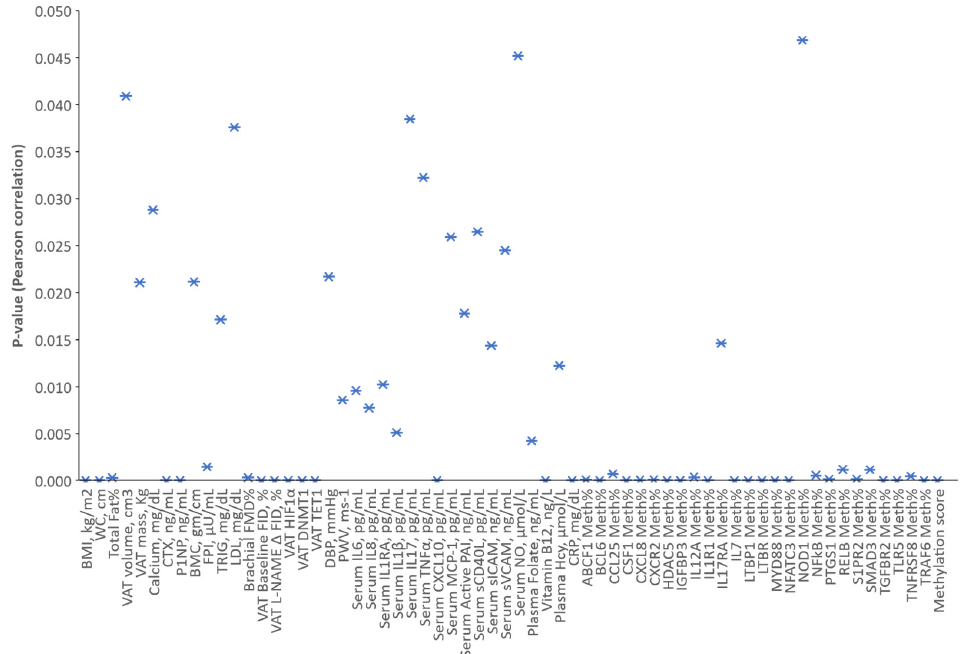
Figure 6. Unadjusted associations between VD levels and cardiometabolic risk factors. A scatterplot for the unadjusted p -values of the association between measured VD concentrations in blood and cardiometabolic risk factors using Pearson or Spearman correlations based on the normality of distribution.